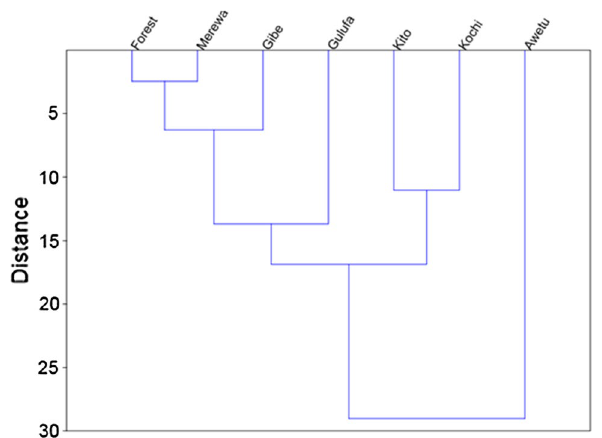
Fig. 3 Cluster analyses of streams from all types of land